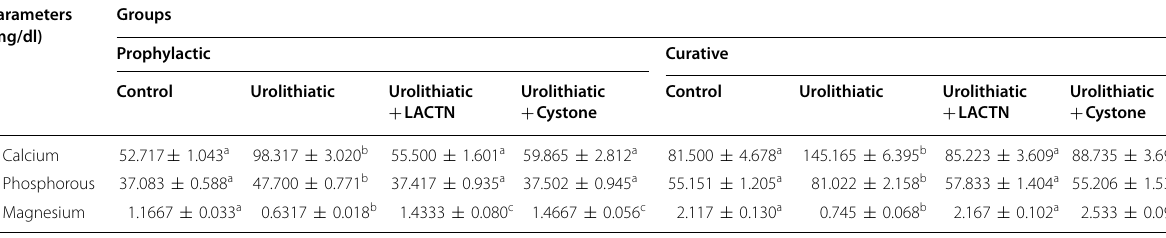
Table 5 Effect of polyherbal formula (LACTN) on some urinary elements of urolithiatic rats Parameters (mg/dl)